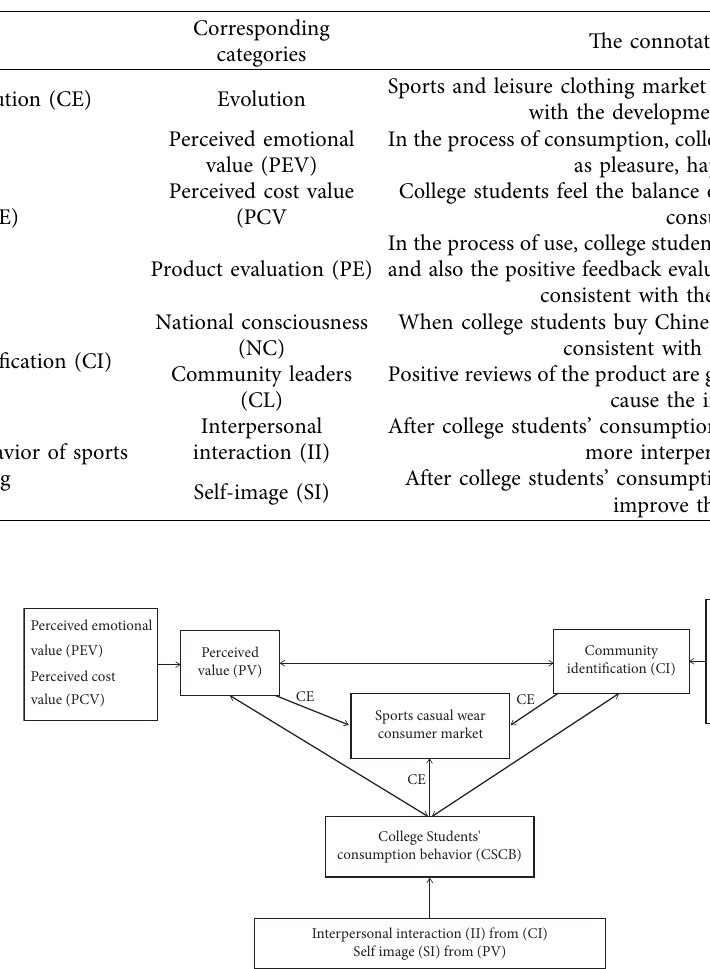
Table 3: The main category and corresponding categories.